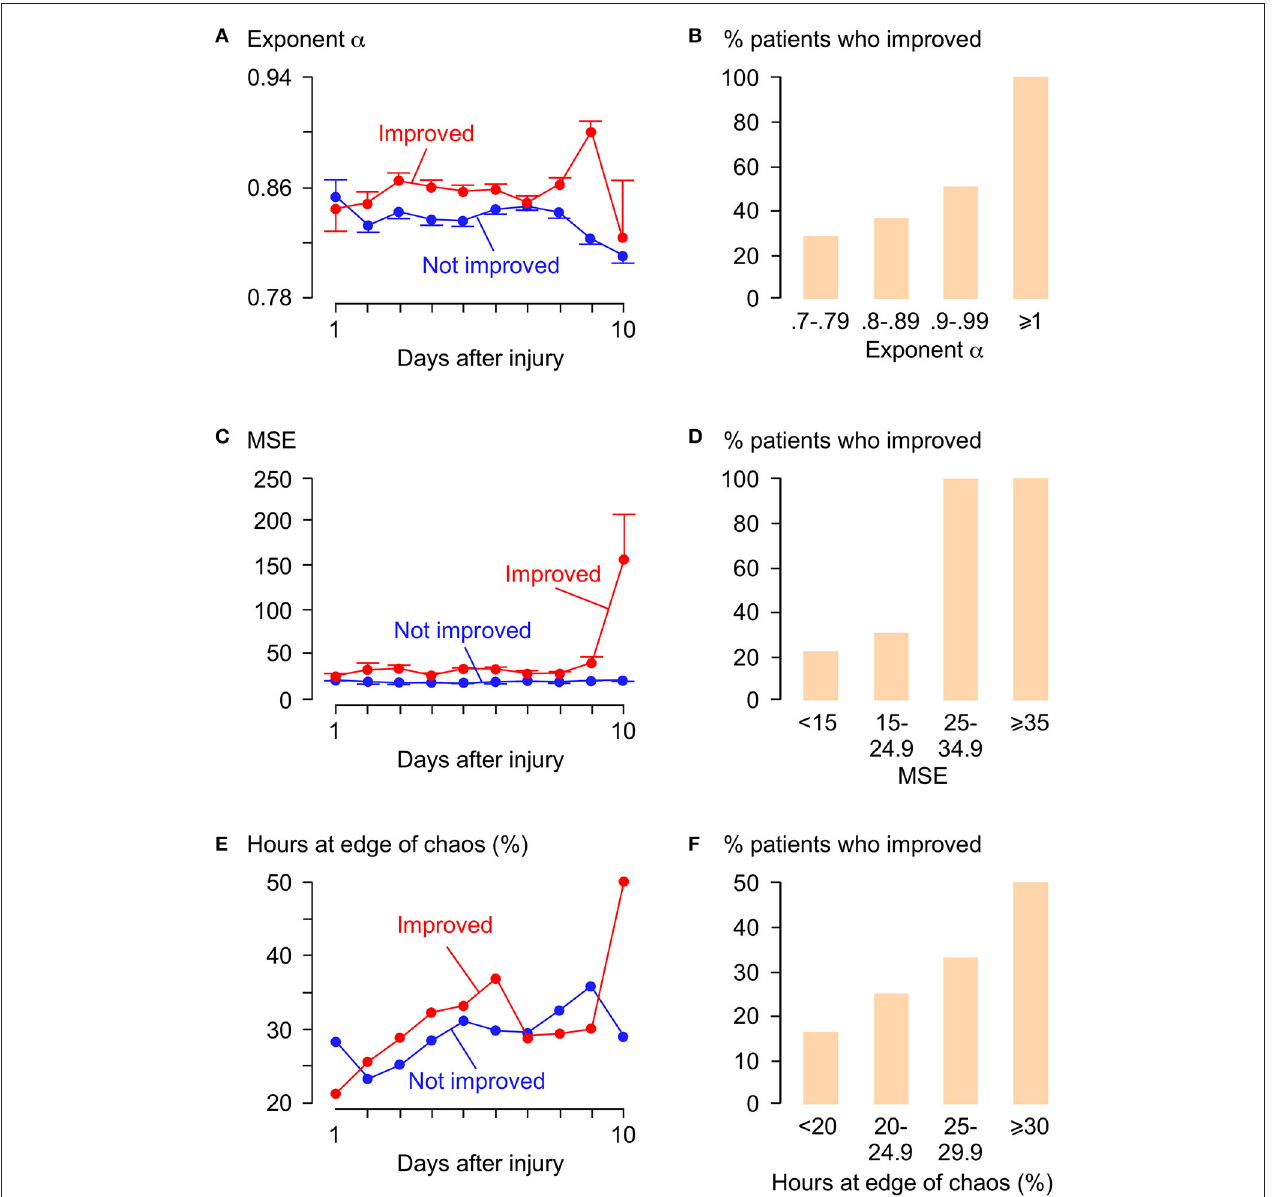
FIGURE 5 | Relations between α , MSE, λ max, and functional outcome. (A) α vs. days after TSCI. (B) % patients who improved vs. α . Trend-line R = 0.92. (C) MSE vs. days after TSCI. (D) % patients who improved vs. MSE. Trend-line R = 0.92. (E) λ vs. days after TSCI. (F) % patients who improved vs. % hours at edge of chaos ( − 0.01 < λ max < 0.01) . Trend-line R = 0.98. For (A,C,E) Patients who improved by ≥ 1 AIS grade (red, 19 patients, 1,996h) and patients not improved (blue, 30 patients, 4,068h), mean ± standard